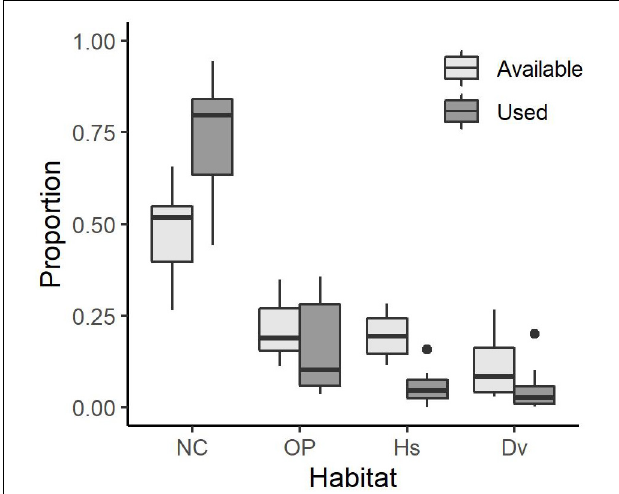
FIGURE 2 | Boxplot showing the proportion of used habitat and mean proportion of available habitat for 14 coyotes with GPS collars in the Greater Toronto Area from 2012 to 2017. The center line represents the median. The limits of the box represent the interquartile range (IQR) and the whiskers represent 1.5 × IQR. Solid circles denote outliers. Habitat types are Natural Cover (NC), Open Paved (OP), Housing (Hs), and Other Developed (Dv).